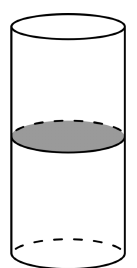
Figure 4 . The Euclidean AdS 3 Black Hole and 3D sine-Liouville